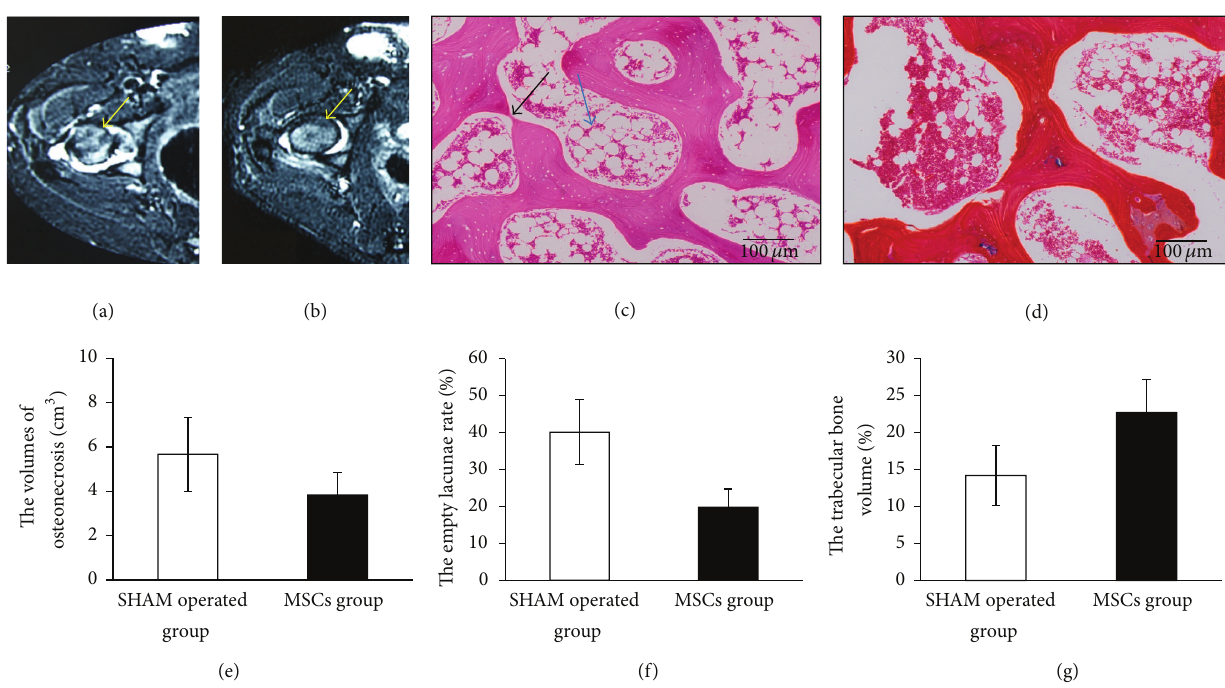
Figure 2: The signs of ONFH in imaging and histopathology at 8th week after treatment. Axial T2-weighted MRI in SHAM operated group showed intra-articular effusion, irregular femoral head margin, and flattened and smaller femoral head (a). Axial T2-weighted MRI in MCSs group showed marked reduction in lesion size, profile rules, and comparatively smooth edge (b). The result from the volumetric analysis showed that the necrotic volume of femoral heads in MSCs group was smaller than that in SHAM operated group ( 𝑝 < 0.05 ) (e). Histological findings show disordered trabeculae, incomplete, significant degeneration, and necrosis with slight fractures in SHAM operated group (c) after eight-week treatment whereas the morphological structure of the MSCs group relatively improved (d). Scale bar 100 𝜇 m . Black arrow shows the slight fracture and blue arrow shows the fat cell hypertrophy. Comparison of the empty lacunae rate between MSCs group and SHAM operated group, the empty lacunae rate in SHAM operated group was significantly higher than that of MSCs group after eight-week treatment ( 𝑝 < 0.05 ) (f). The percentage of trabecular bone volume in MSCs group was significantly higher than that in SHAM operated group after eight-week treatment ( 𝑝 < 0.05 ) (g).